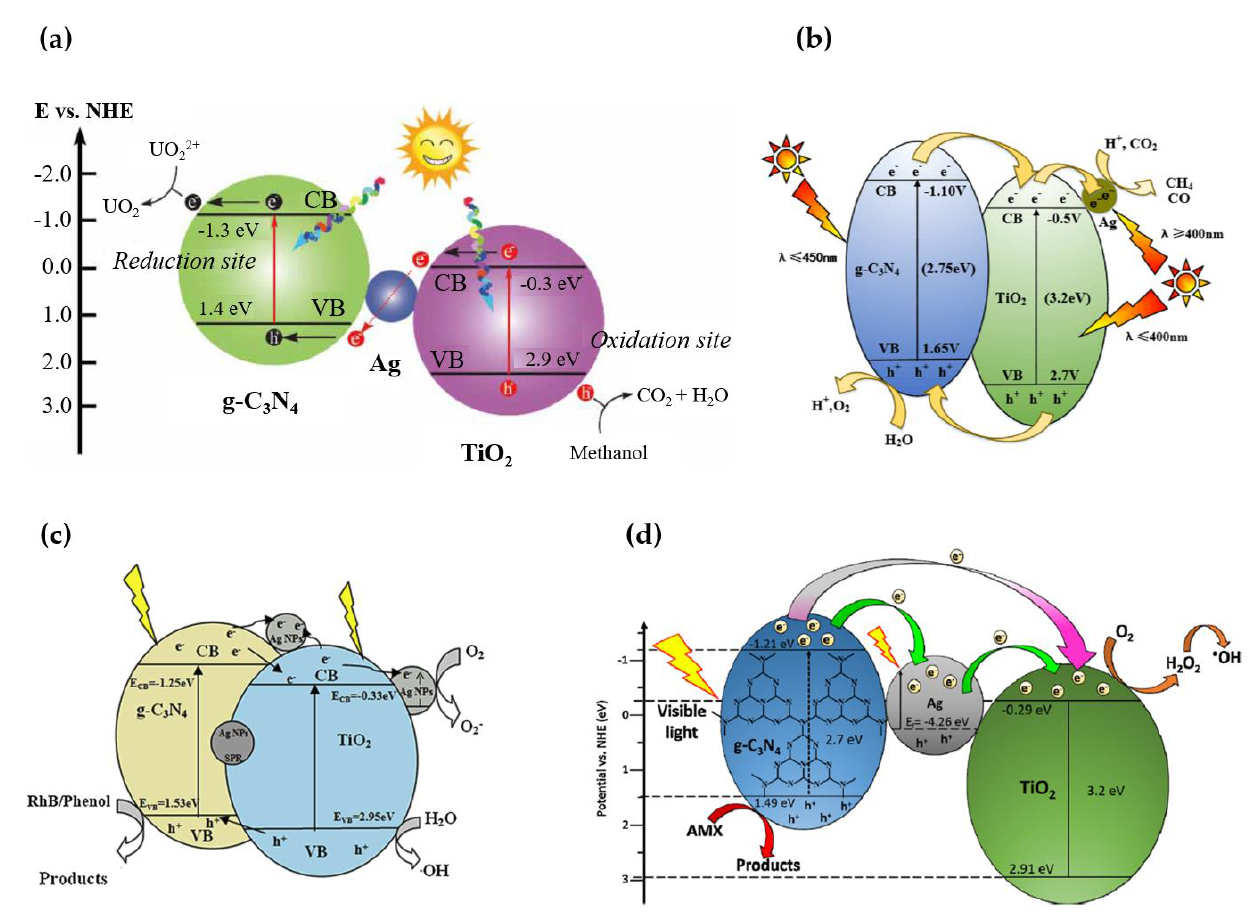
Figure 12. Direct Z-scheme of the photocatalytic mechanism of Ag/TiO 2 /g-C 3 N 4 heterostructure ( a ) (Reprinted with permission from [45]; Copyright 2022, IWA Publishing); Type II heterojunction of Ag/TiO 2 /g-C 3 N 4 accompanied by the Schottky barrier ( b ) (Reprinted with permission from [122]; Copyright 2017, Elsevier) and ( c ) (Reprinted with permission from [116], Copyright 2020, Elsevier); photocatalytic mechanism of Ag/TiO 2 /g-C 3 N 4 under visible light ( d ) (Reprinted with permission from [120], Copyright 2015, Elsevier).